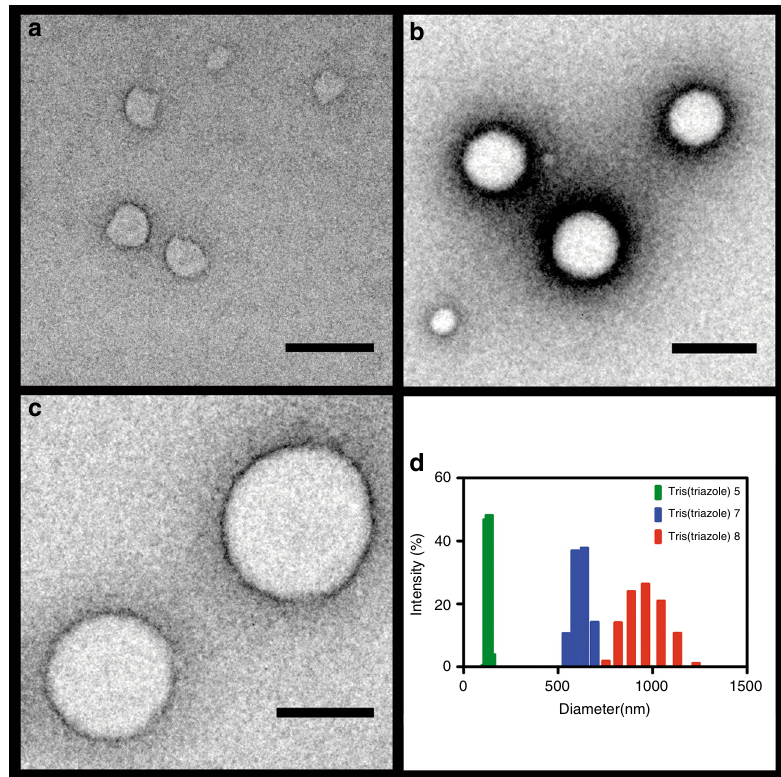
Fig. 2 Characterization of peptide nanospherical structures. TEM images of negatively stained self-assembled peptide nanospheres formed from oligotriazole peptide 5 ( a ), 7 ( b ), and 8 ( c ). Scale bar denotes 500 nm. d DLS corresponding to 10 mM aqueous solution of tris(triazole) peptide 5 ( green ), 7 ( blue ), and 8 ( red